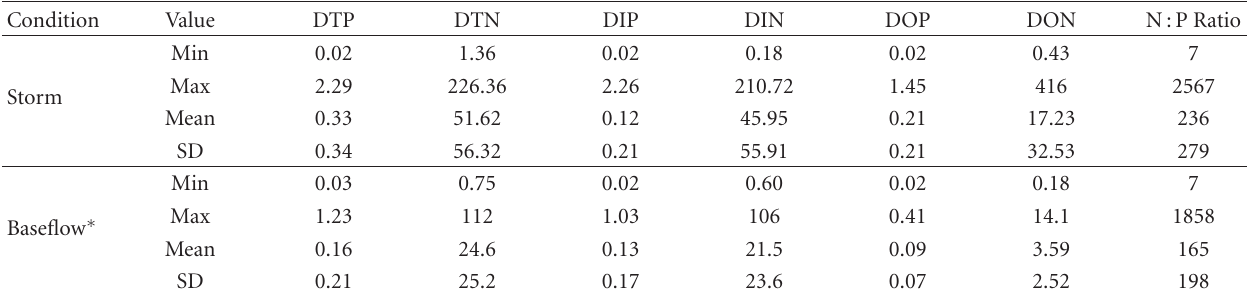
Table 1: Summary of forested runo ff nutrient concentrations ( µ mol L − 1 ) and the molar N:P ratio in storm and baseflow states for the complete dataset (all sites).